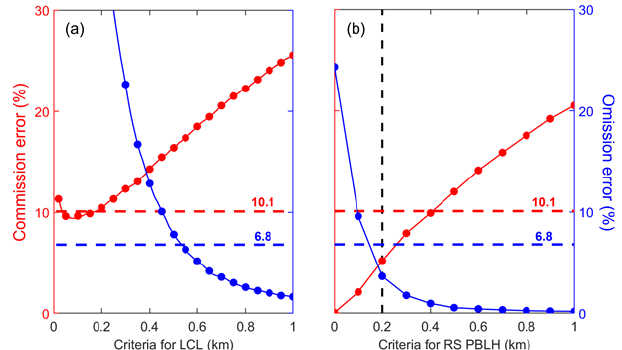
Figure 5. Commission errors and omission errors of coupled cloud identifications (a) for different criteria for the lifted condensa- tion level (LCL) and (b) for different criteria for the planetary boundary layer height (PBLH). “Criteria for LCL” means coupled clouds are identified if | CBH − LCL | < criteria for LCL. Similarly, “Criteria for RS PBLH” means coupled clouds are identified if CBH − RS PBLH < criteria for RS PBLH. The dashed red and blue lines indicate the commission and omission errors, respectively, for the DTDS algorithm. CBH stands for cloud-base height, and RS stands for radiosonde. By using ∼ 7500RS profiles, the cloud cou- pling state derived from the virtual potential temperature method (Sect. 3.1) is considered as the ground truth for evaluation.